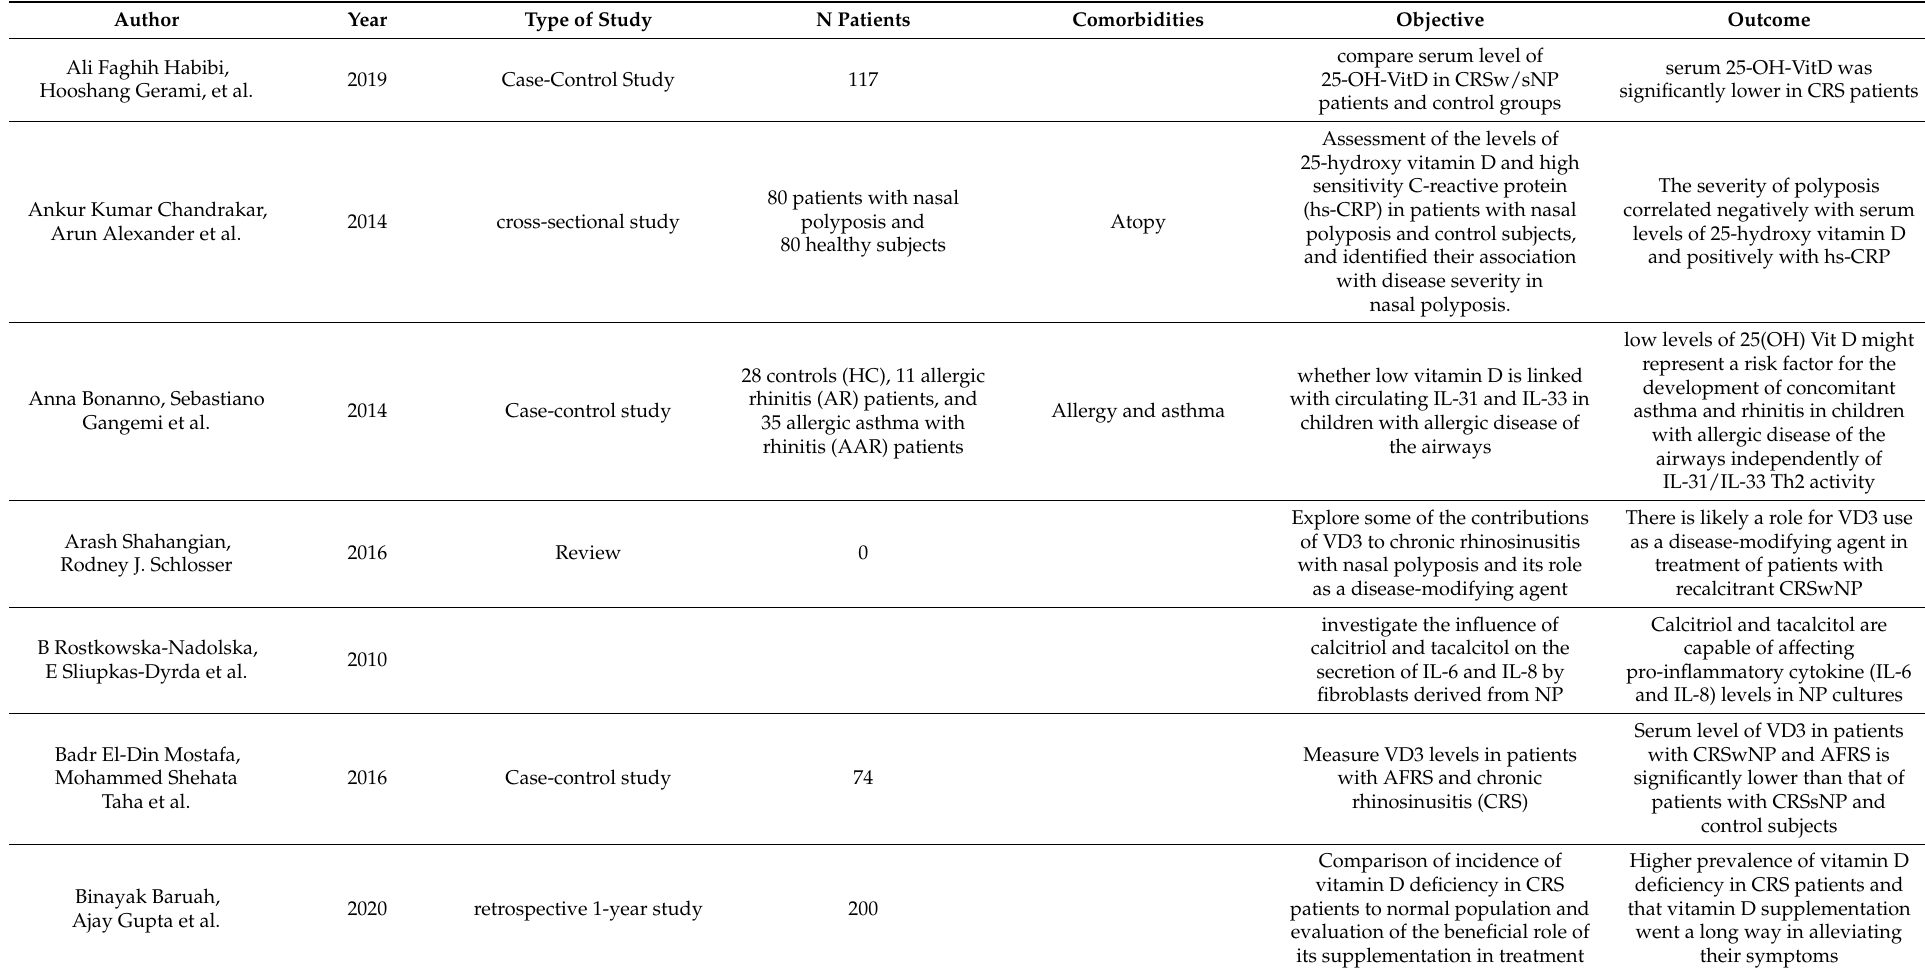
Table 1. Articles collected and